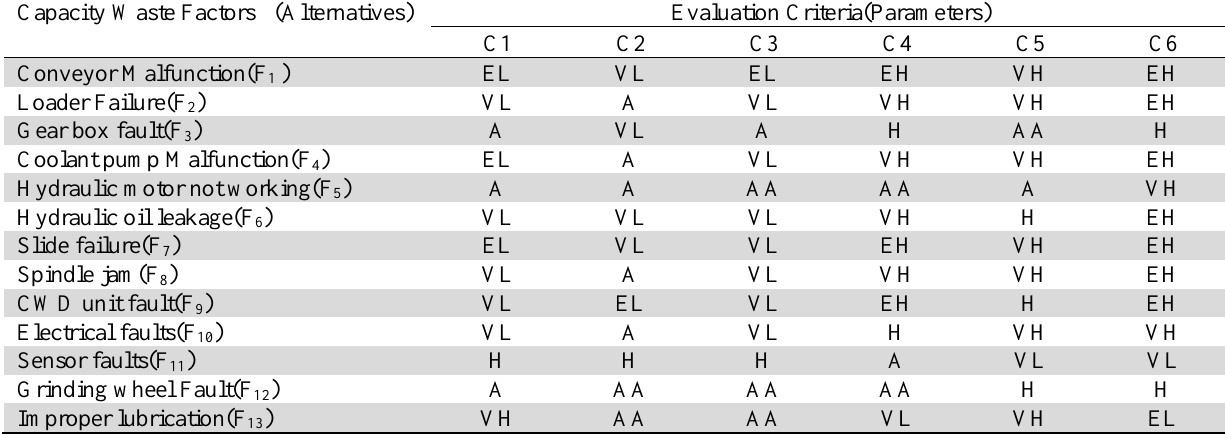
Linguistic decision matrix of capacity waste alternatives for all evaluation criteria Capacity Waste Factors